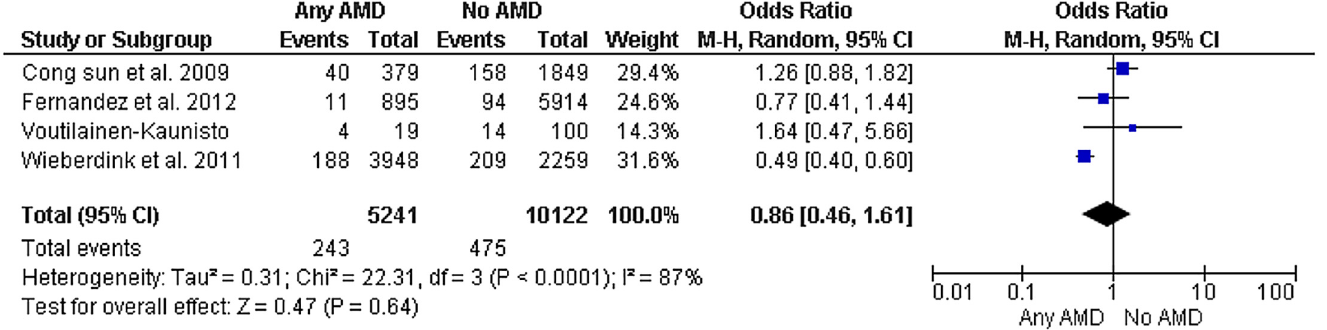
Fig 3. High-quality Studies of AMD and risk of stroke. Diamond indicates the overall summary for the analysis, width of the diamond represents the 95% CI (Confidence Interval), and boxes represent the weight of individual studies in the pooled analysis. Trials to the left of the vertical line showed a reduction in the risk of stroke events favored AMD; those to the right showed an increase in risk favored No AMD. Abbreviations: AMD, Age-related macular degeneration; M-H,